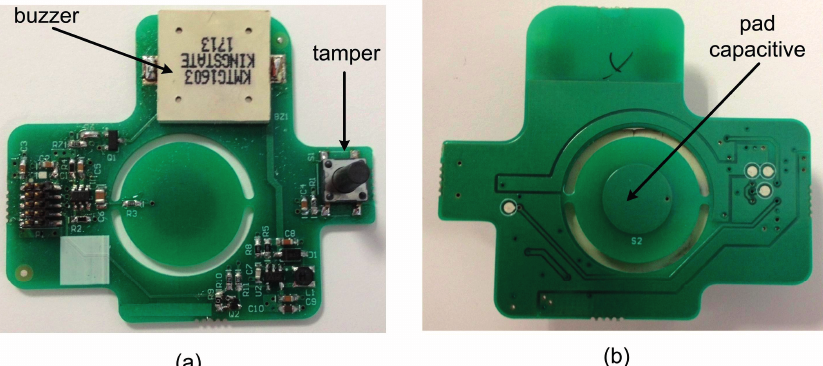
Figure 7. Secondary board. ( a ) Top; ( b ) Bottom.